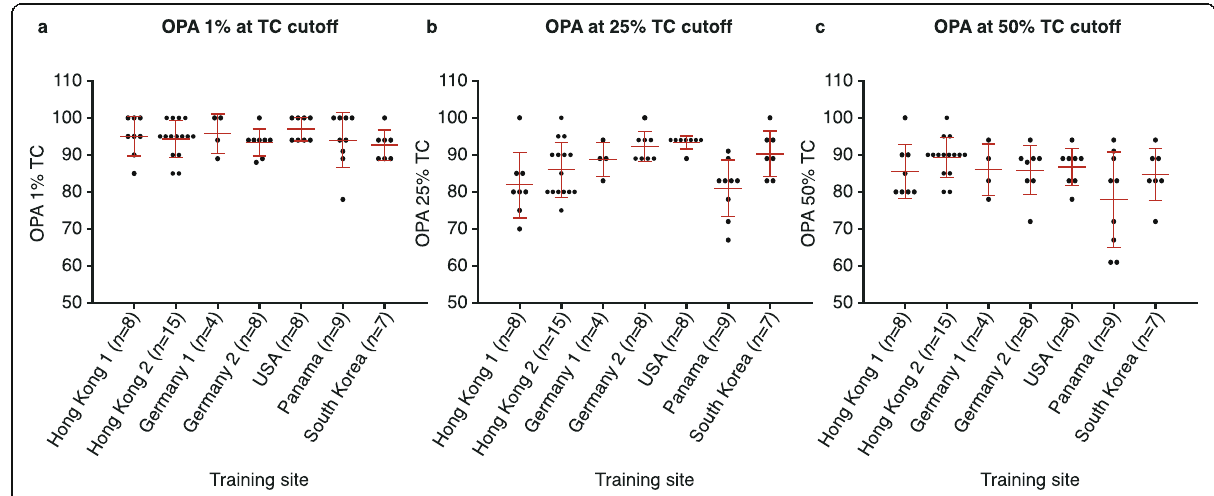
Fig. 2 Overall percentage agreement for the ( a ) 1% TC cut-off, ( b ) 25% TC cut-off and ( c ) 50% TC cut-off (TCs) between geographical regions for NSCLC samples stained using the VENTANA PD-L1 (SP263) assay ( n = 59), NSCLC, non-small cell lung cancer; OPA, overall percentage agreement; TC, tumour cell. Red lines represent standard deviation. Assay was carried out according to manufacturers ’ recommended